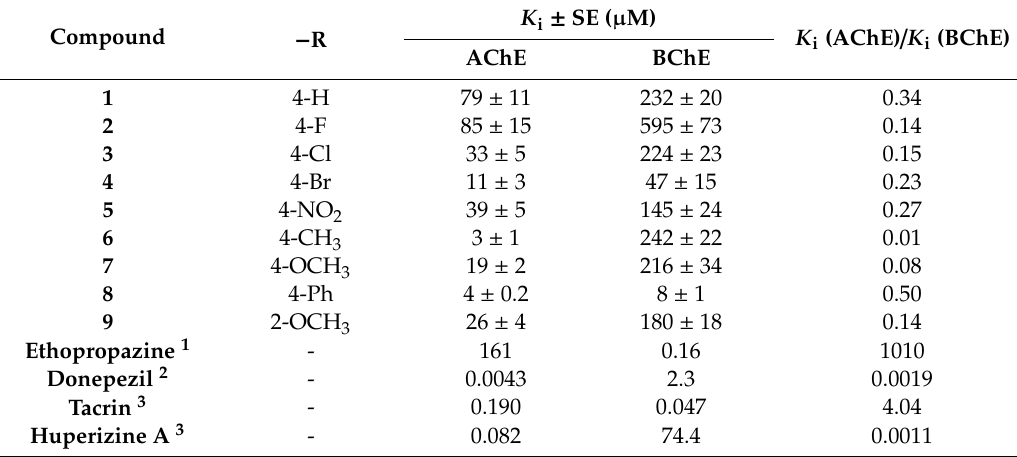
Table 2. Reversible inhibition of AChE and BChE by nicotinamide derivatives ( 1 - 9 ) and known ChE acting drugs (reversible inhibitors). Dissociation inhibition constants ( K i ± standard error) were determined from at least three experiments. R denotes substituent and its position on the phenyl ring. K i ± SE ( µ M) Compound − R K i (AChE) / K i (BChE) AChE BChE 1 4-H 79 ± 11 232 ± 20 0.34 2 4-F 85 ± 15 595 ± 73 0.14 3 4-Cl 33 ± 5 224 ± 23 0.15 4-Br 11 ± 3 0.23 4-NO 2 145 ± 24 0.27 4-CH 3 4-OCH 3 4-Ph 0.50 2-OCH 3 26 ± 4 0.14 Ethopropazine 1 - 161 0.16 - 0.0043 2.3 0.0019 0.190 0.047 0.082 74.4 0.0011 1 K 2 K 3 IC i values from [47], i values from [48,49] and 50 values from